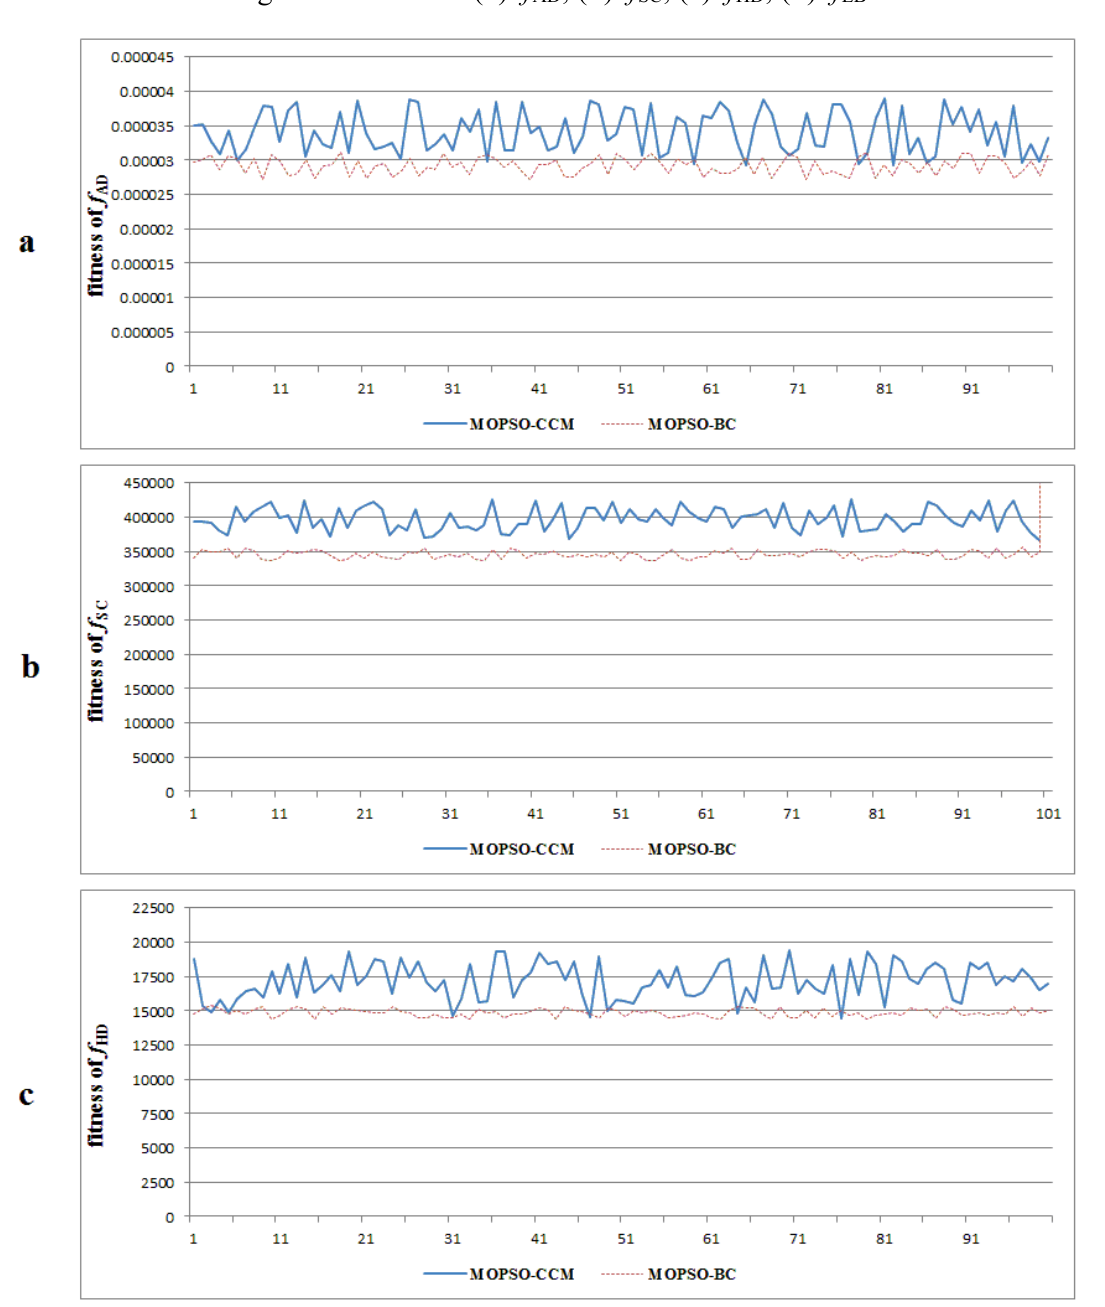
Figure 13. The fitness curves of the four sub-objectives obtained by MOPSO-CCM and MOPSO-BC with weighted scenario L: ( a ): f